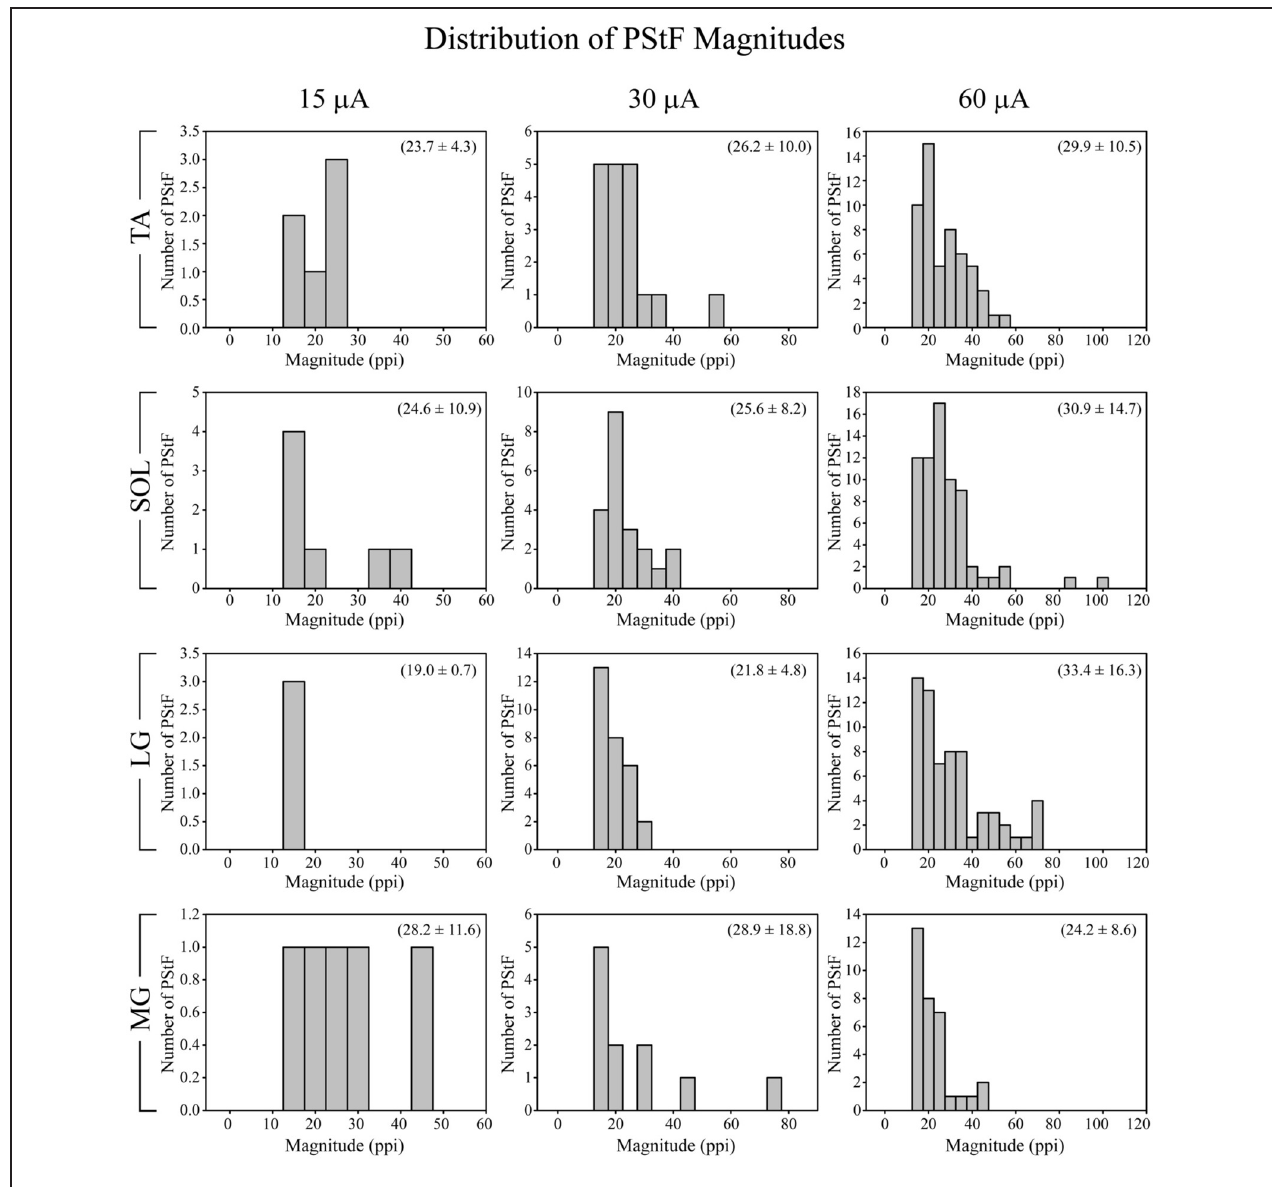
FIGURE 4 | Distribution of PStF magnitudes for ankle muscles at 15, 30, and 60 µ A stimuli. The magnitudes are expressed as peak percent increase (ppi) above baseline. The values given in